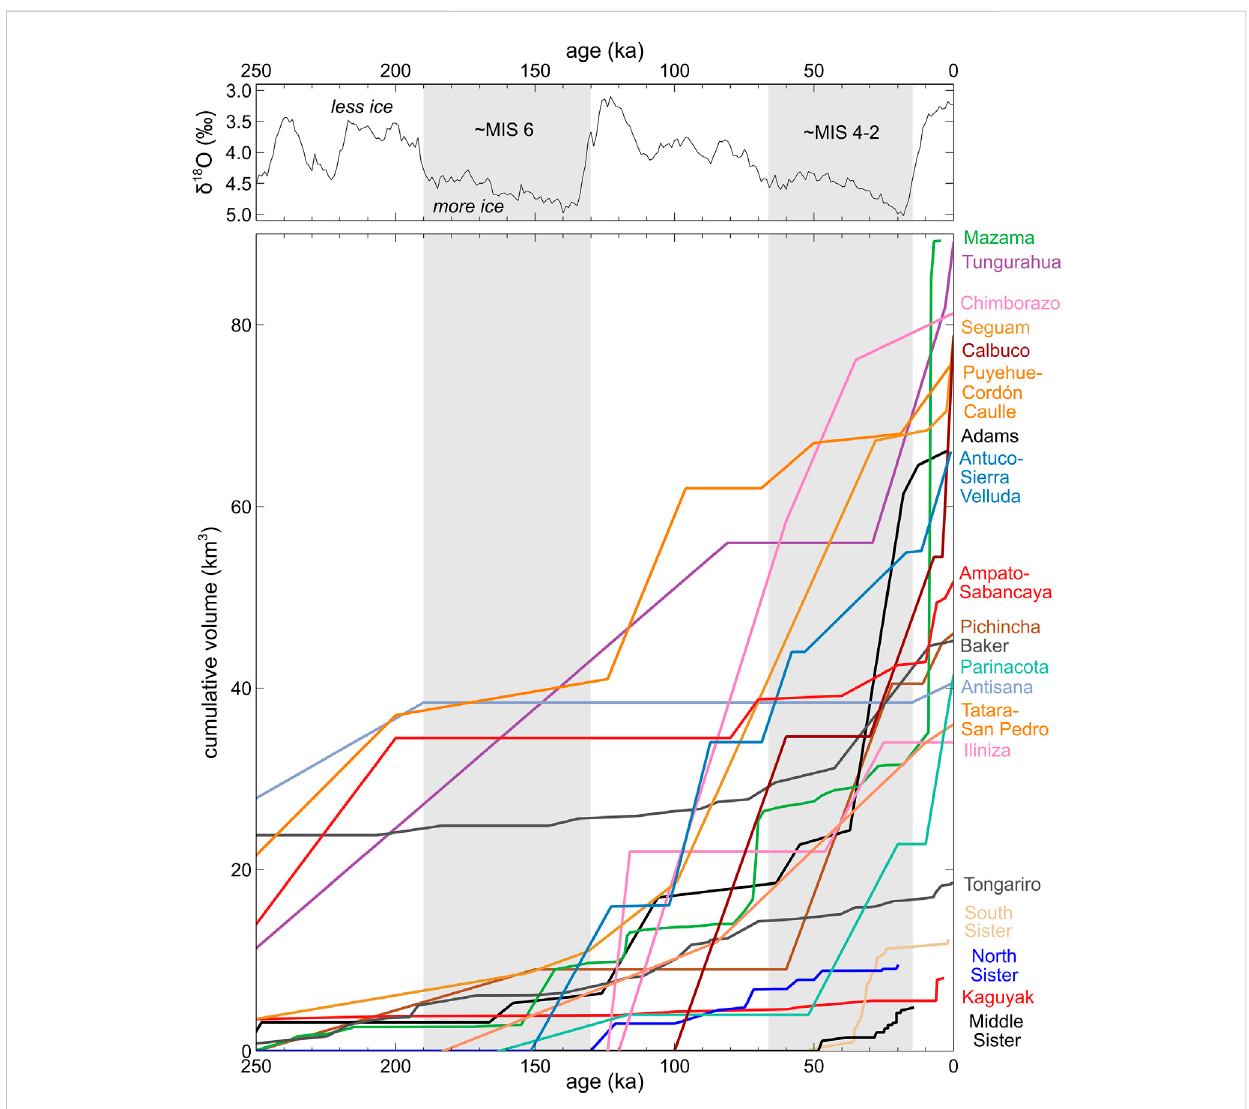
FIGURE 3 Summary of benthic δ 18 O climate proxy data (Lisiecki and Raymo, 2005) and edi fi ce growth rates for 20 of the volcanic systems assessed in this review since 250 ka. In upper and lower panels, the approximate positions of glacial MIS stages are shaded in grey, and unshaded regions are interglacial MIS stages. Cumulative volcano edi fi ce growth volumes andages arefrom thestudies inTable 1,whicharecompiled intheSupplementary File S1.Of the total 33 volcanic systems considered in this review, 13 are excluded from this fi gure because they are older than ~100 ka (Paniri, Aucanquilcha), or theirtime-volumedataareoflowresolutionorabsent(Tanaga,Akutan,Fisher,Katmai cluster[including MountKatmai],MountRainier,MountSt.Helens, Mount Hood, Shasta, Lassen, Popocatepétl, El Misti), or their total volumes exceed 100 km 3 (Ruapehu); note that Kulshan caldera is counted with Mount Baker. To fi t on the diagram, cumulative volume sums begin from ~0 km 3 for Pichincha and